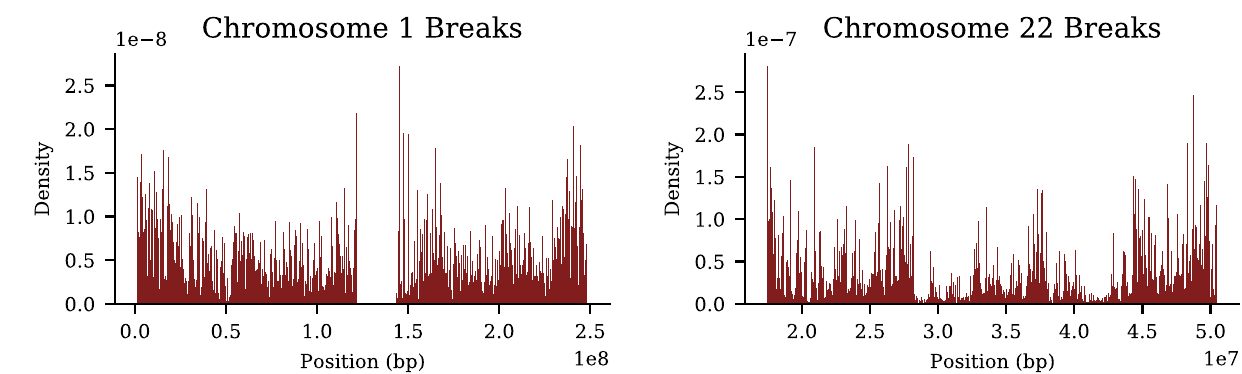
Figure 12. Cumulative recombination length of chromosomes 1 and 22 (i.e., total Morgan length). Red line is the siblings-pair method applied to 21 k European ancestry sibs from UK Biobank. Gray line is from deCODE (Science 2019) result using population of Iceland.